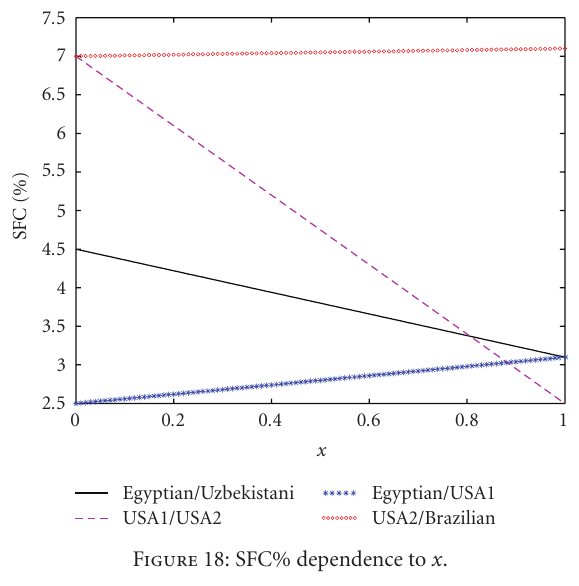
Figure 18: SFC% dependence to x .